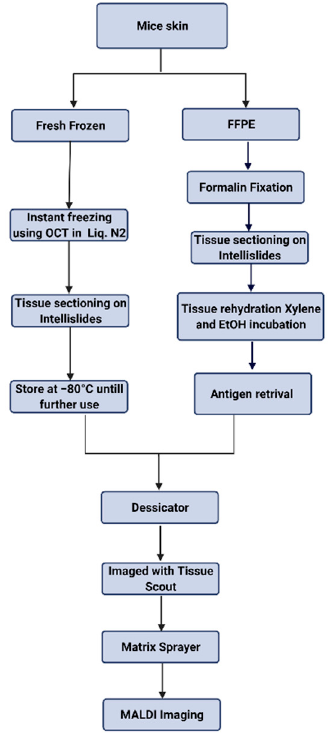
Figure 4. Schematic representation of sample processing.